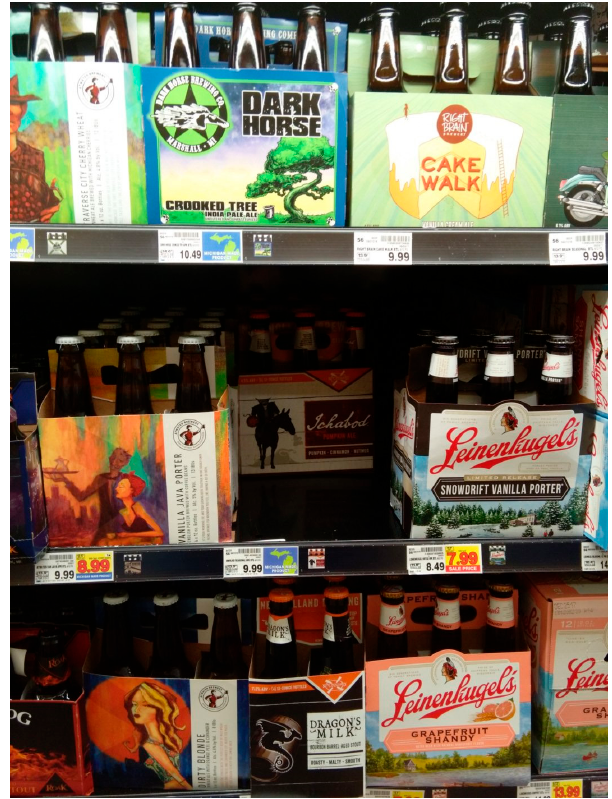
Figure 2. Example of craft beer facings at a grocery-format retailer.